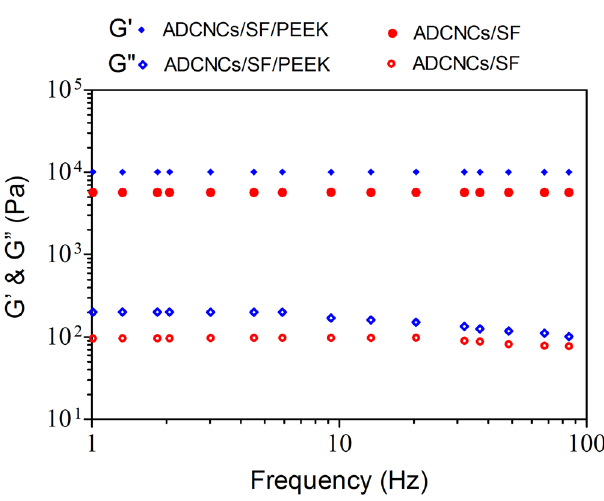
Figure. 3. Frequency sweep of ADCNCs/SF and ADCNCs/SF/PEEK hydrogels.